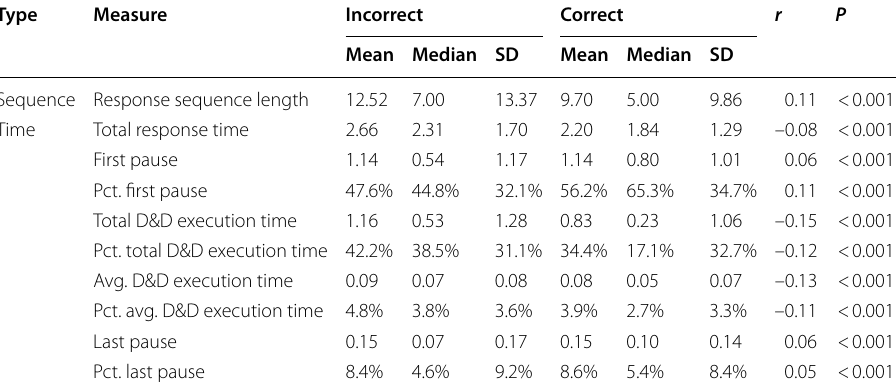
P‑values of Mann–Whitney U tests and the effect sizes of the comparisons ( r ) are